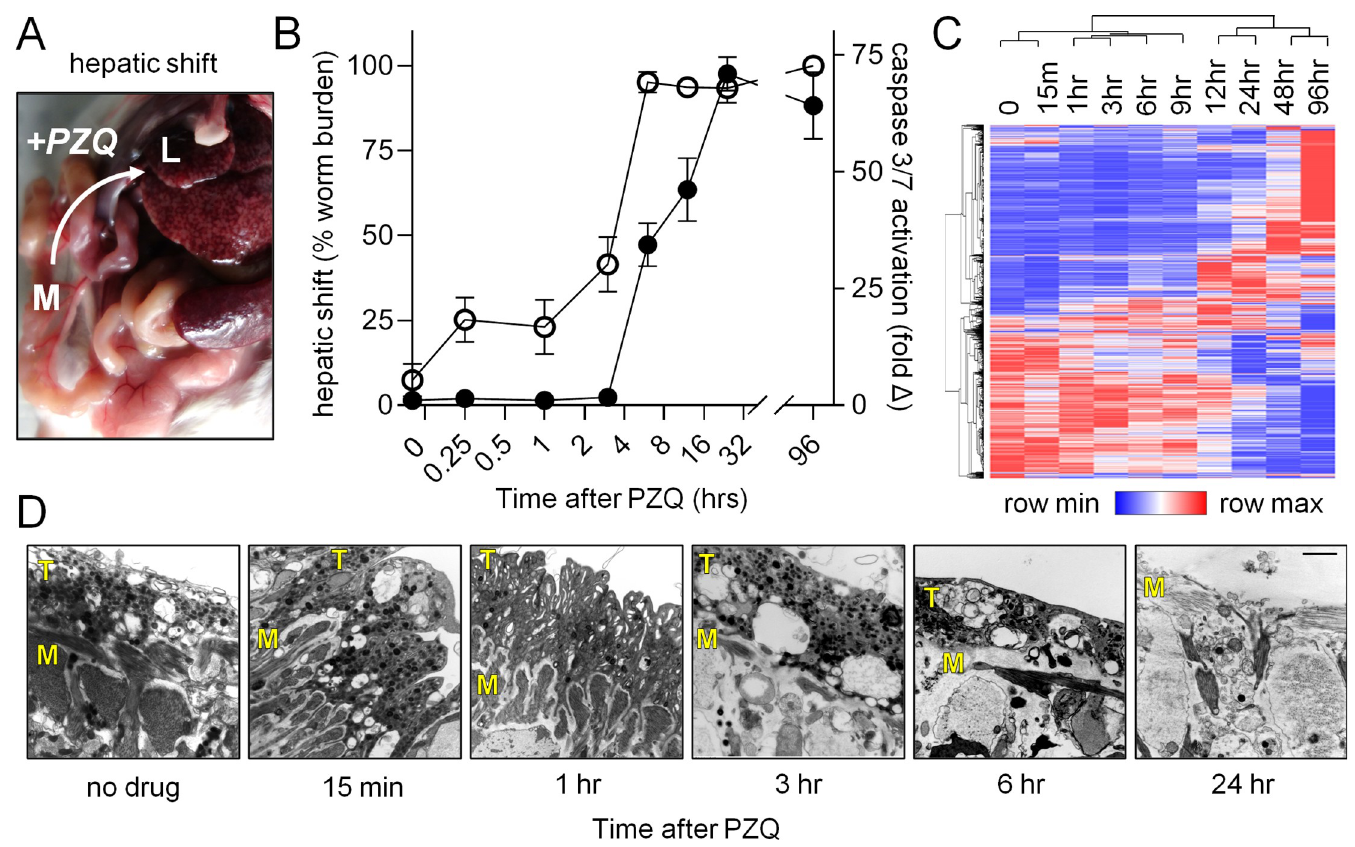
Fig 1. Parasite death occurs following in vivo hepatic shift. (A) A curative dose of PZQ (400 mg/kg) was administered to mice 7 weeks post-infection (n = 4 mice per time point) and worms were harvested at various time points from either the mesenteries (M) or the liver (L). (B) Time course of parasite hepatic shift (open symbols, left axis) and pro-apoptotic caspase-3/7 activation (solid symbols, right axis). (C) Changes in gene expression in worms harvested at various timepoints following PZQ treatment in B. Heatmap reflects minimum (blue) and maximum (red) z-score values for all transcripts showing > 1 log 2 fold change and an average TPM > 3 (see S1 File for raw data). (D) Transmission electron microscope (TEM) images of the dorsal male body wall showing the time course of tissue damage following in vivo PZQ treatment. T = tegument. M =